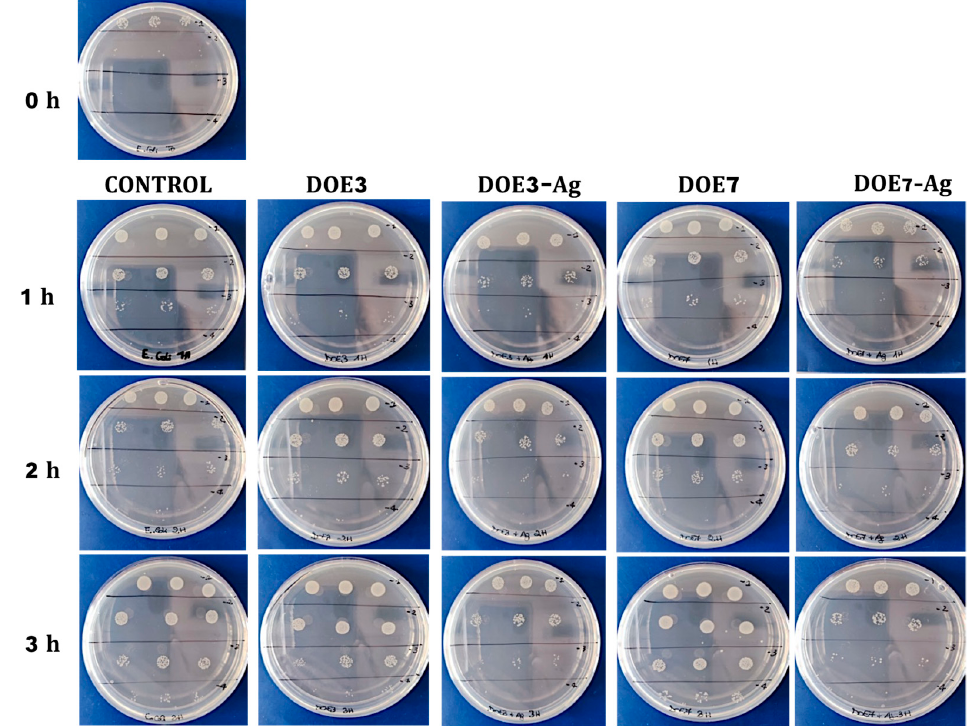
Figure 11. Photographs of Petri dishes obtained from E. coli culture without any mat (control) and cultures with blank PSU and PSU-Ag mats at different serial dilutions from 10 − 1 to 10 − 4 and different sampled times (0, 1, 2, and 3 h). Table 6. Bacterial population (CFU/mL) measured for control, uncoated samples (DOE3 and DOE7), and coated samples (DOE3-Ag and DOE7-Ag) at different times. Data are reported as mean value ± SD from two independent experiments, each in triplicate. Bacterial Population (CFU/mL)